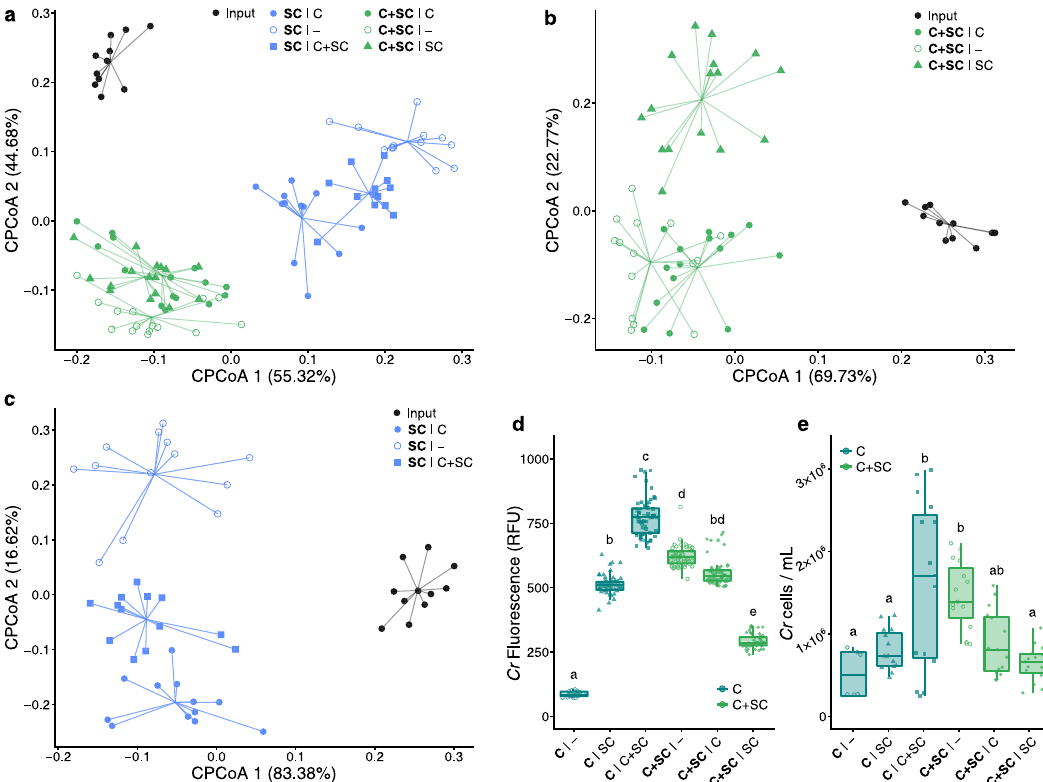
Fig. 6 Physical proximity to Cr is required for the establishment of phycosphere bacterial communities. Strain-level beta-diversity analyses of Bray – Curtis dissimilarities of bacterial SynComs (SC, n = 37), and synthetic phycospheres (SC + C, n = 46), grown in a split gnotobiotic system. Constrained PCoA is shown for all samples (21% of variance; P < 0.001, a ), or a subset of samples, depending on the content of the vessel (39.4 – 39.5% of variance; P < 0.001, b , c ). d , e Cr growth across conditions measured using relative chlorophyll fl uorescence ( n = 60, d ) and algal cell densities ( n = 15, e ). A Kruskal – Wallis test followed by a Dunn ’ s post hoc was used to assess signi fi cant differences among groups ( P < 0.05). Corresponds to experiment H (Supplementary Fig. 1h and Supplementary Table communities where the bacterial SynCom was incubated alone (Fig. 6c; SC |C or SC |C + SC vs. SC | – ; P = 0.001), possibly by